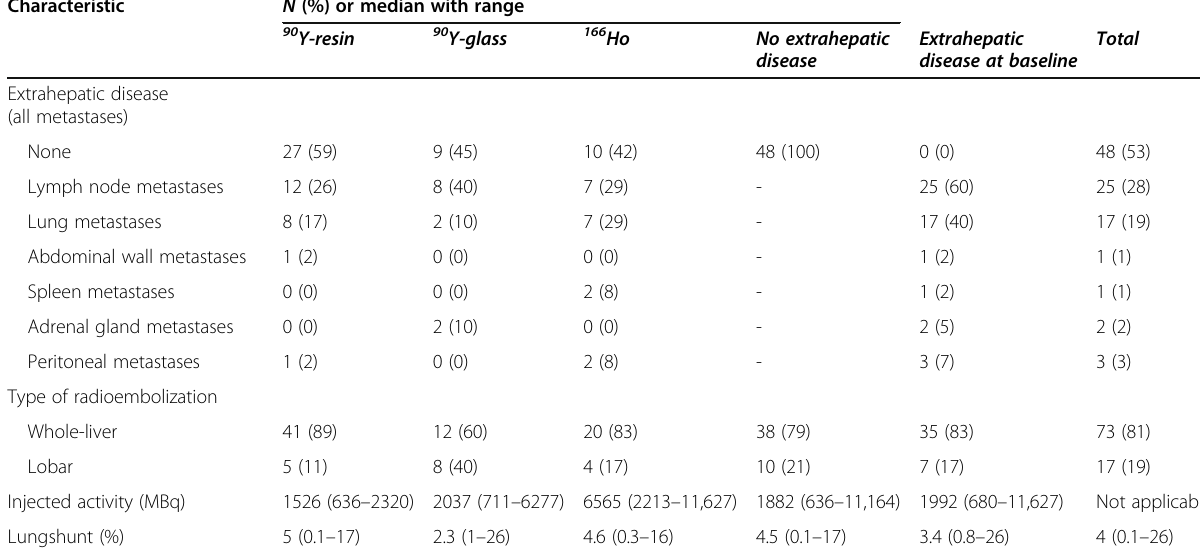
Table 1 Baseline and treatment characteristics (Continued)